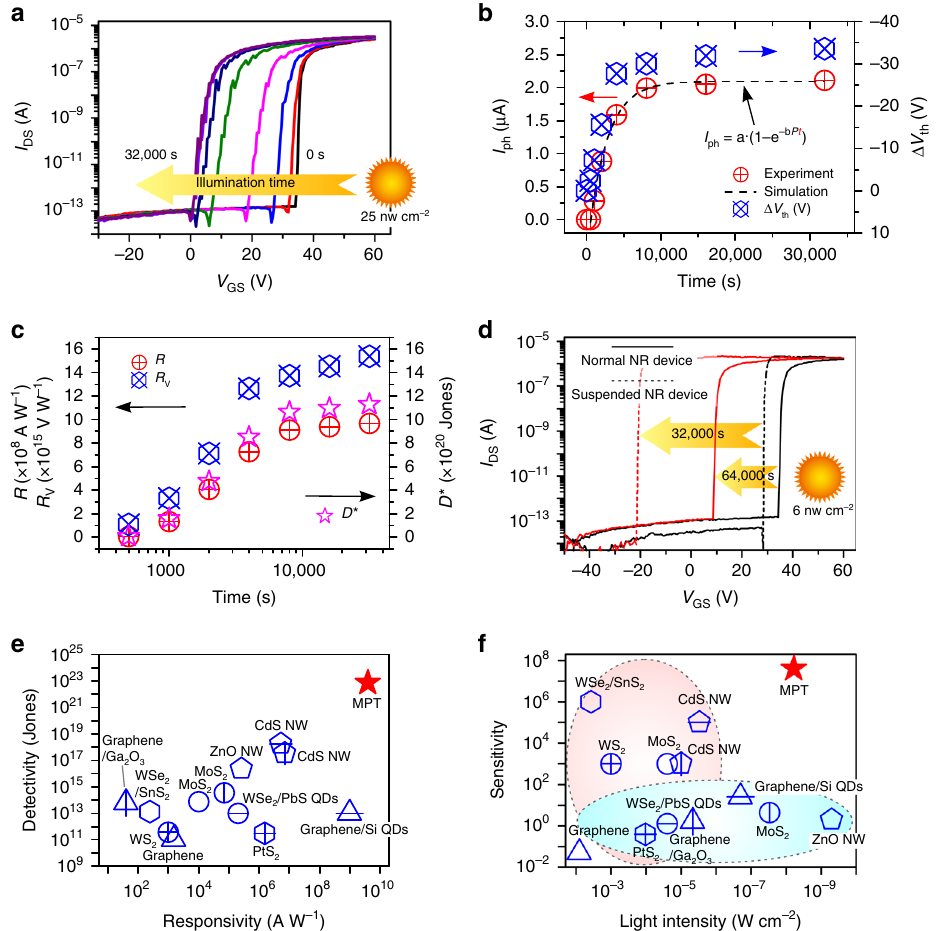
Fig. 5 Charge-storage accumulative effect. a Electrical transfer curves of the CdS NR phototransistor measured in the dark after 0 – 32,000 s of light irradiation (25 nW cm − 2 ). b Photocurrents at V GS = 34 V, threshold voltage shifts, and c photocurrent responsivity, voltage responsivity, and detectivity at different irradiation time, which were extracted from the electrical transfer curves in a . d Electrical transfer curves of the normal and suspended CdS NR phototransistors after the irradiation by an ultraweak light of 6 nW cm − 2 for a longer time of 64,000 and 32,000 s, respectively. e Responsivity, detectivity, and f light intensity, sensitivity of several typical state-of-the-art low-dimensional semiconductor-based